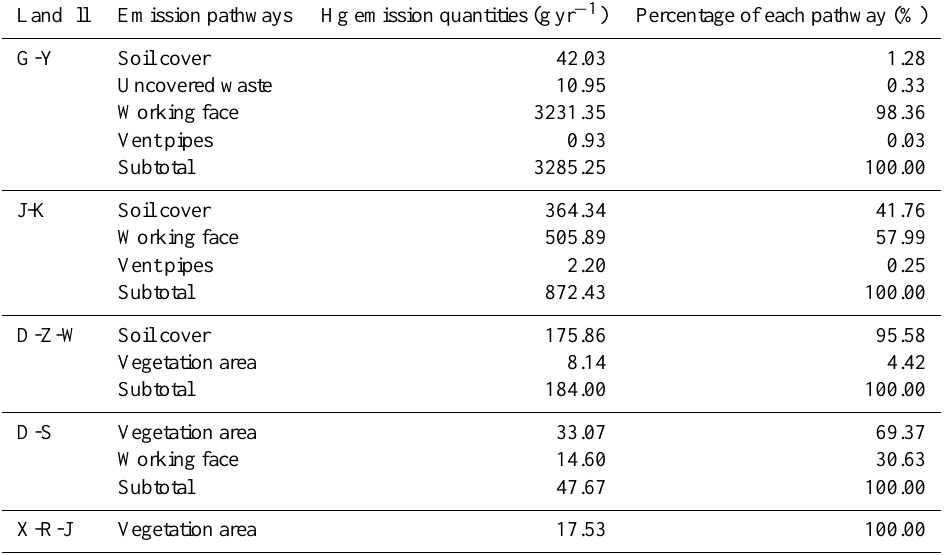
Table 5. Estimation of annual Hg emissions from the studied landfills in